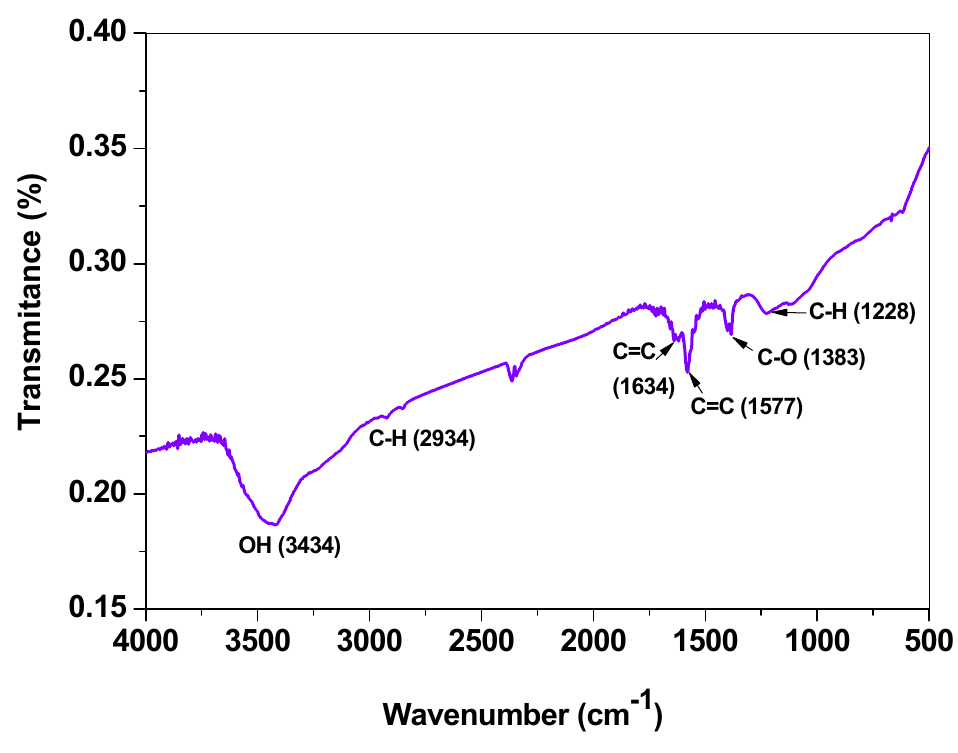
Figure 3. The FTIR spectrum of EGr sample embedded in KBr pellet.